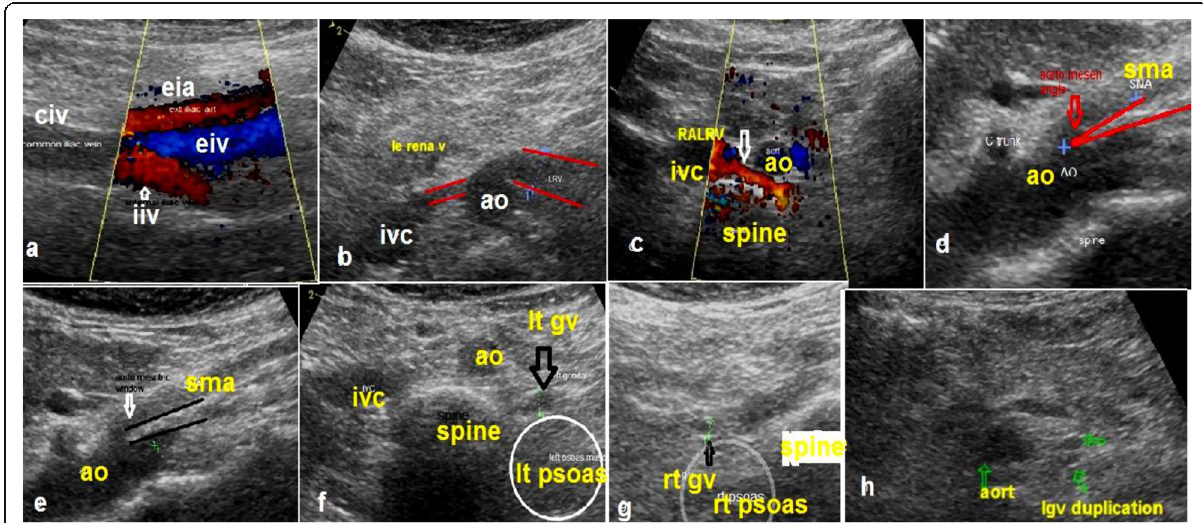
Fig. 1 a – h Trans-abdominal color Doppler and gray scale images showing a external iliac vein (eiv.) (coded in blue) just dorsal to the external iliac artery (eia) (coded in red) and the internal iliac vein (iiv) (coded in red) and the common iliac vein (civ) formed by the union of the two veins. b Left renal vein (between red lines) as it passed anterior to the aorta (ao) to join the IVC (ivc). c Retro-aortic left renal vein (open white arrow) (RALRV) passing posterior to the aorta (ao) anterior to the spine to join the IVC (ivc). d Measurement of the aorto-mesenteric angle (red lines) between aorta (ao) and superior mesenteric artery (sma). e Measurement of the aorto-mesenteric window (black lines) between aorta (ao) and superior mesenteric artery (sma). f Showing the left gonadal vein (open black arrow) (lt gv) anterior to the left psoas muscle on the left side of the aorta. g Showing right gonadal vein (open black arrow) (rt gv) anterior to the right psoas muscle on the right side of the spine. h Showing duplicated left gonadal vein (lgv) (open green arrows) just to the left of the aorta (aort) (open green arrow)